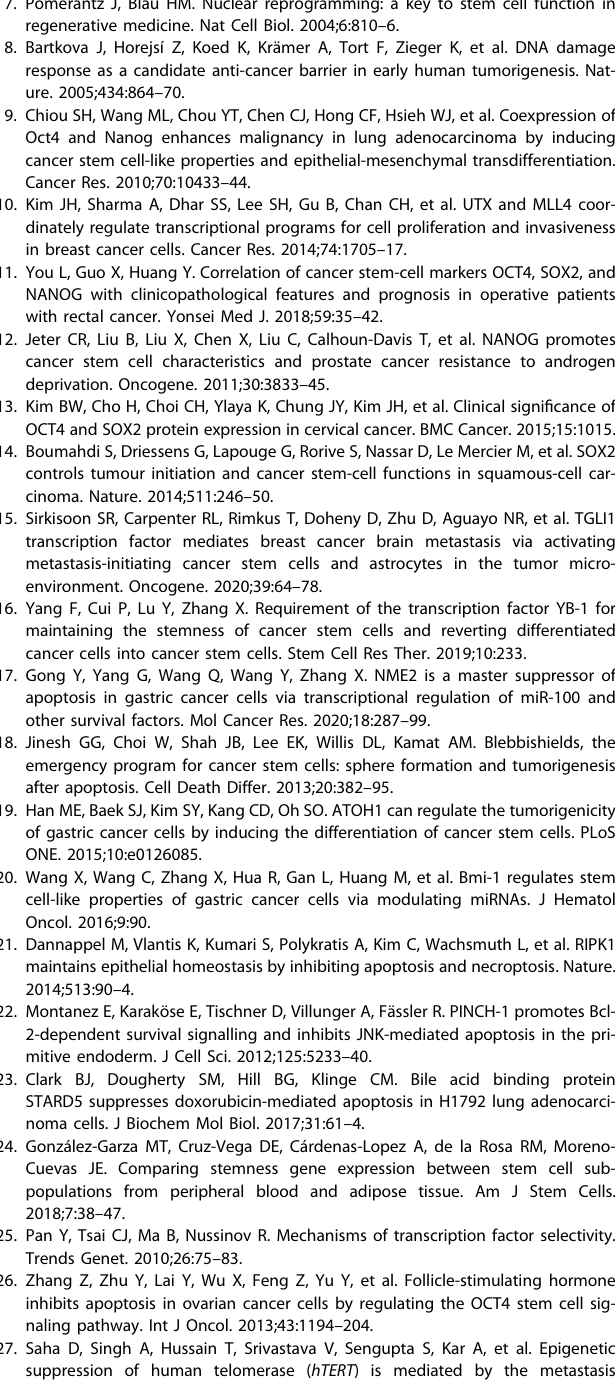
Fig. 6 Mechanism of NME2-mediated apoptosis in gastric cancer stem-like cells from solid tumors of patients. a Effects of NME2 silencing and rescue on the expressions of anti-apoptosis genes in gastric cancer stem-like cells sorted from the solid tumors of patients. The gastric cancer stem-like cells were transfected with NME2-shRNA to silence the NME2 expression. To rescue the NME2 expression, the NME2-silenced cells were transfected with the plasmid expressing NME2. At 48 h after NME2 rescue, the expression levels of RIPK1, STARD5and LIMS1 were examined with western blot and quantitative real-time PCR ( ** p < 0.01). In western blot, β -tubulin was used as a control. b Immunohistochemical analysis of the expressions of anti-apoptosis genes (LIMS1, RIPK1, and STARD5) in the solid tumors of mice. The NME2-knocked-down gastric cancer stem-like cells from the solid tumors of patients were injected into nude mice. Four weeks later, the solid tumors of mice were subjected to immunohistochemical analysis. Brown indicated the proteins labeled and blue represented nuclei stained by hematoxylin. Scale bar, 20 μ m. c Model for the mechanism of the NME2-mediated maintenance of stemness of gastric cancer stem- like